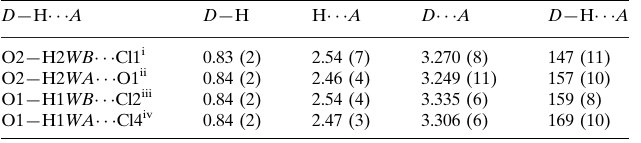
Hydrogen-bond geometry (A˚ , (cid:3)